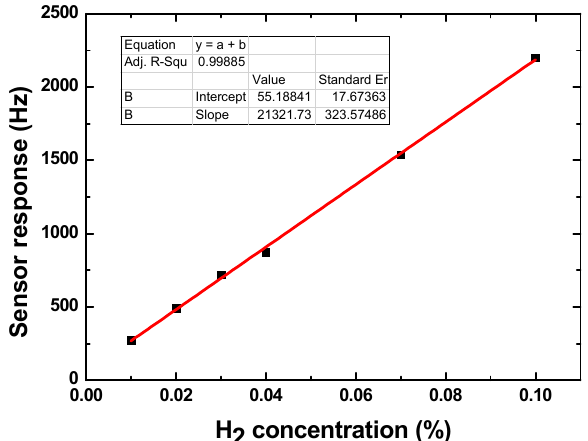
Figure 8. The sensitivity evaluation of the 40 Pd-Ni alloy thin-film coated sensing device.